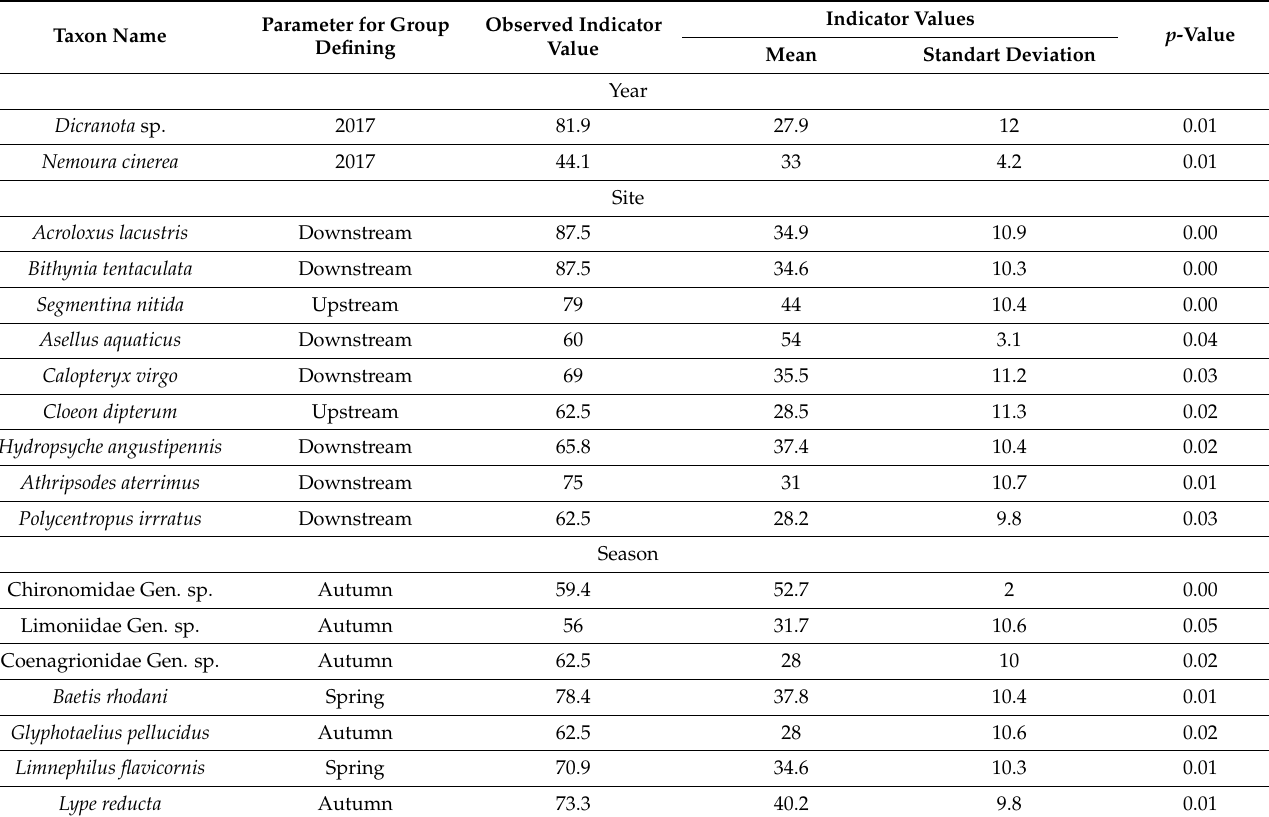
Table 4. Indicator species analysis of the Rusinupe showing indicator values of significant indicator species (groups are defined by year, season, and stream